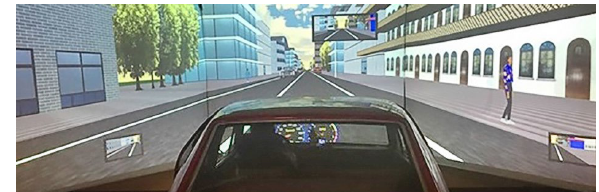
Figure 1. Test at the driving